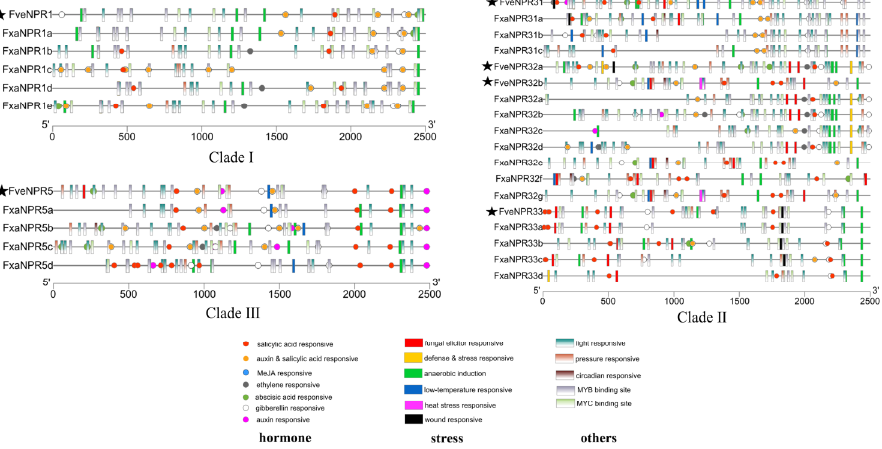
Figure 5. The predicted cis-elements in the promoter regions of NPR -like genes in Fragaria vesca and F. × ananassa . The promoter sequences ( − 2500 bp upstream of the starting code ATG) of 48 strawberry NPR -like genes were analyzed by PlantCare. The geometries in different colors and shapes indicate elements involved in different processes, with cycles for hormone-responsive, filled rectangles for stress-responsive, and rectangles with gradient color for the others.